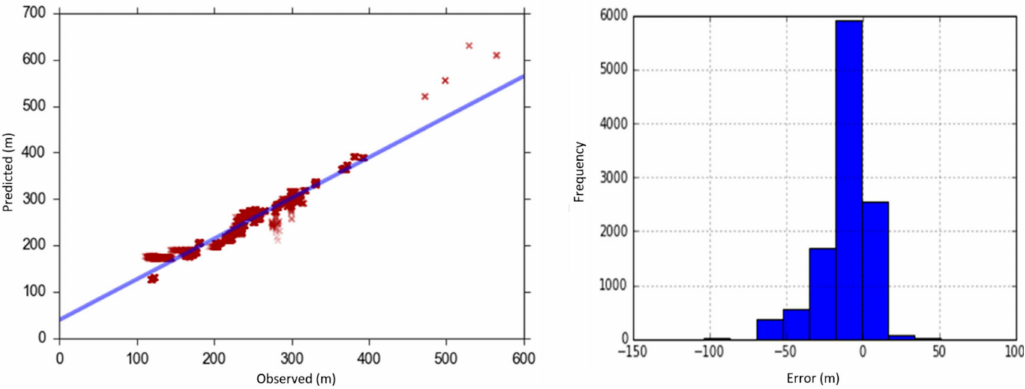
Figure 3. Scatter plot of observed versus simulated groundwater heads and distribution of calibration